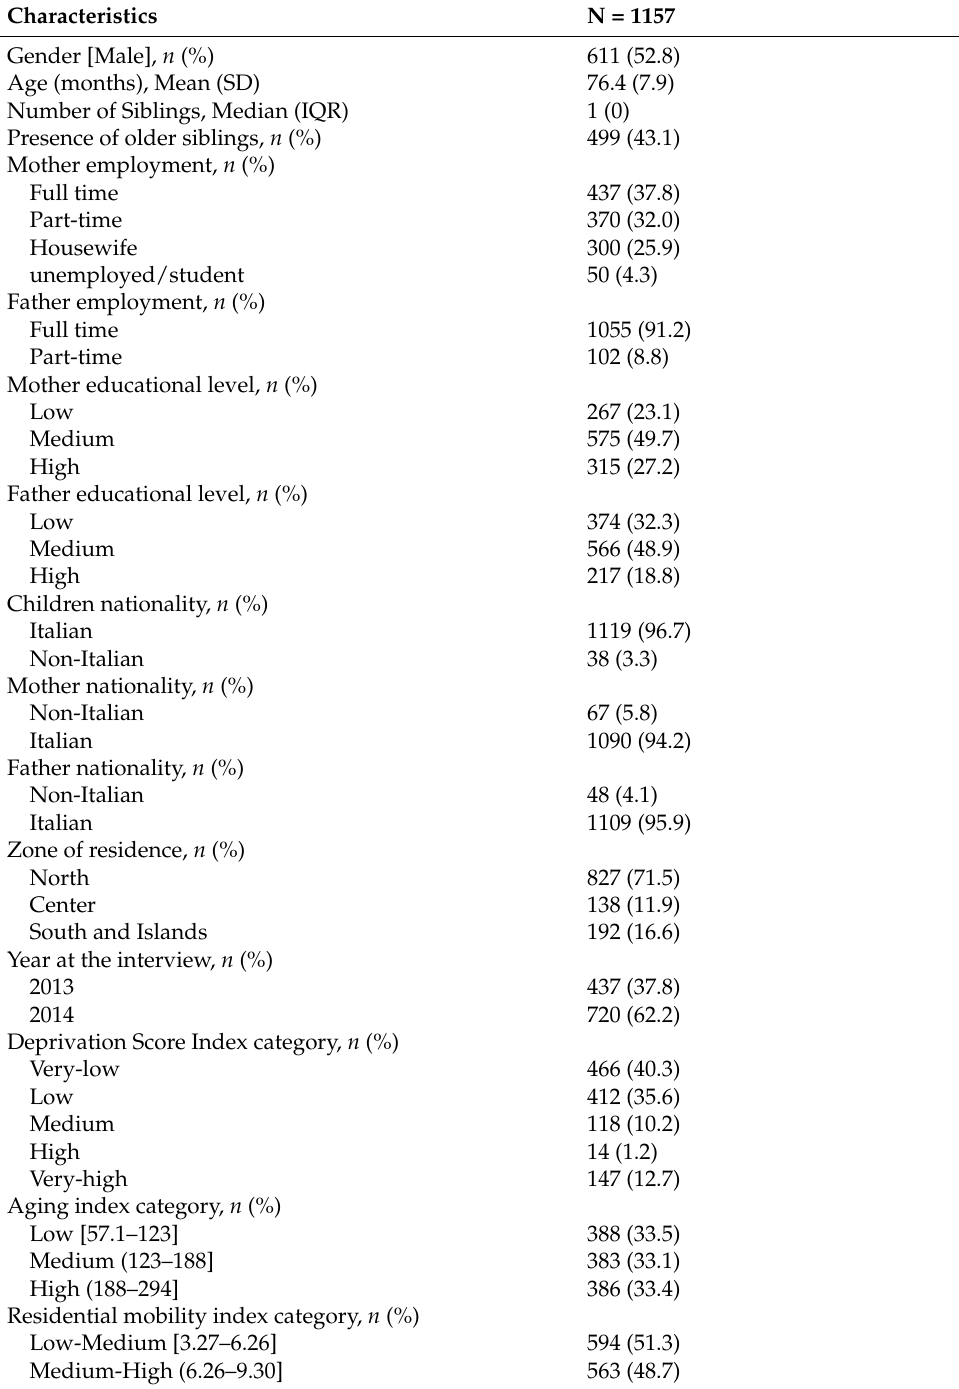
Table 1. Main characteristics of the children included in the